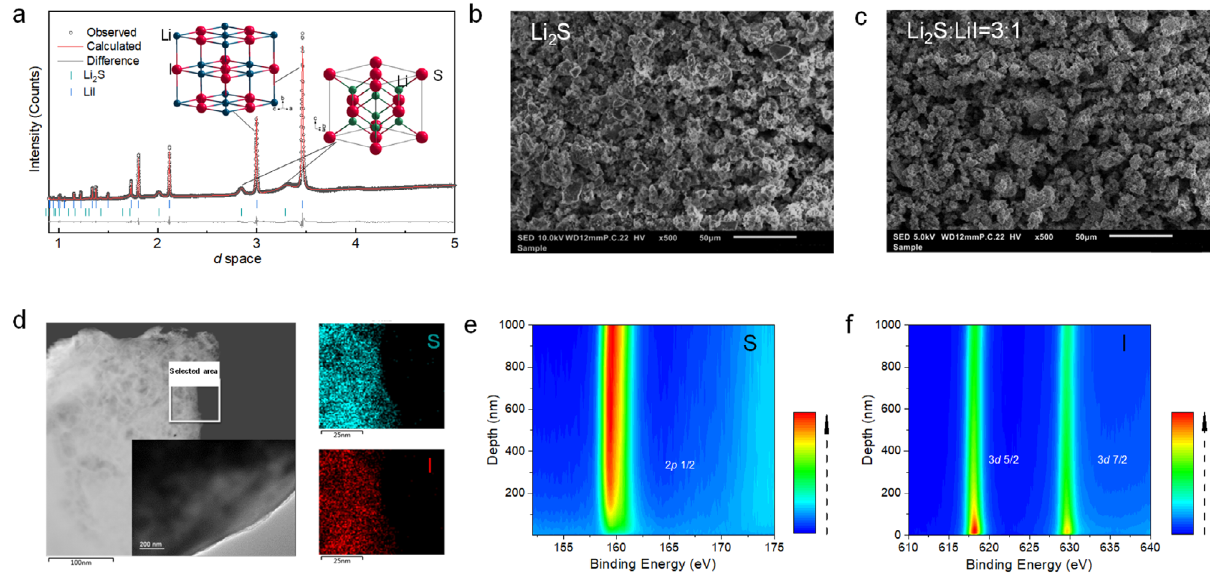
Fig. 2 Structural and chemical characterization of the positive electrode active materials. a XRD pattern of the Li 2 S-LiI materials. The pattern is fi t with the Rietveld method as implemented in GSAS. The inset represents the cubic structure of Li 2 S and LiI (space group of Fm3m). b , c , d SEM images, TEM images, and energy spectrum of the Li 2 S and Li 2 S-LiI (3:1) materials; e , f S 2p and I 3d XPS depth pro fi les of the pristine Li 2 S-LiI (3:1)